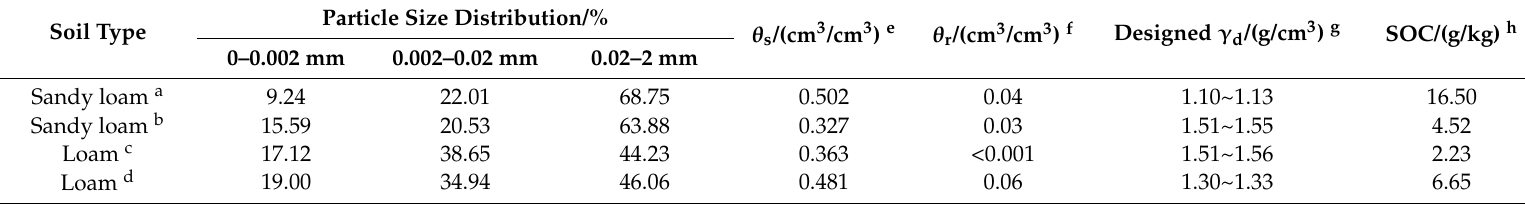
Table 1. Particle size distribution of the experimental